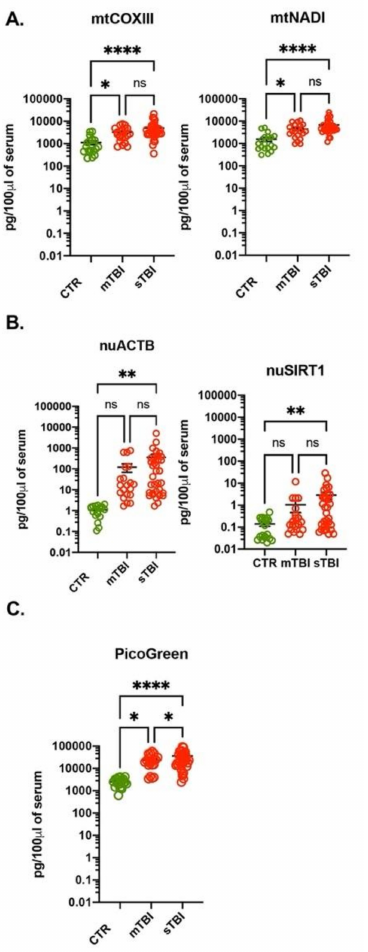
Figure 4. Traumatic brain injury patients have high amount of ccf-DNA. The amount of mtDNA ( A ) and nuDNA ( B ) was analyzed with qPCR using mtCOXIII, mtNADI and nuACTB and nuSIRT1 primers, respectively, in serum of healthy volunteers ( n = 20), mTBI ( n = 20) and sTBI ( n = 33). ( C ) The amount of ccf-DNA measured with PicoGreen in healthy volunteers, mTBI and sTBI. The amount of DNA is expressed as pg of DNA in 100 µ L of serum. * p < 0.05, ** p < 0.01, **** p <